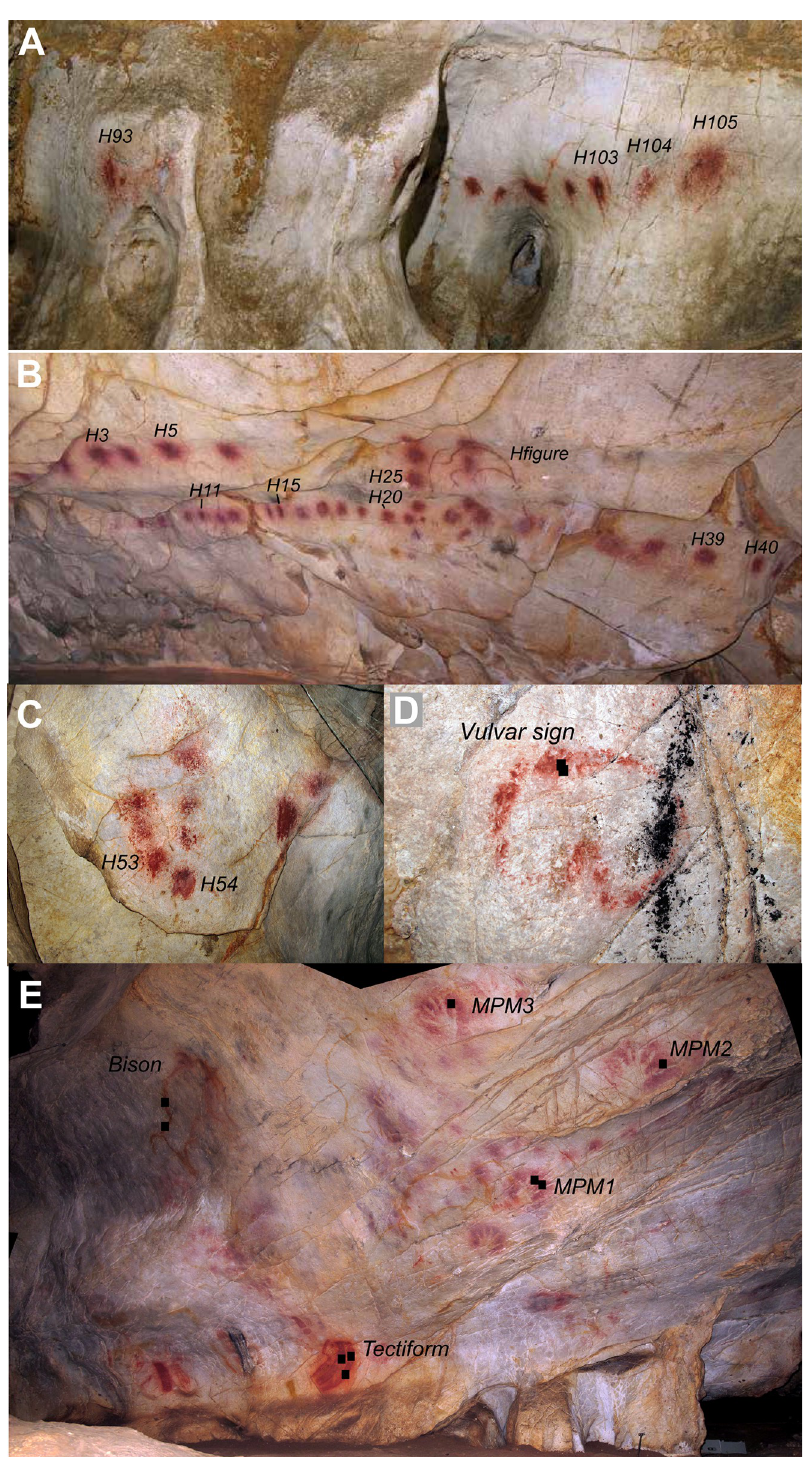
Fig 2. Pictures of the main paintings analysed in the present study. Black squares indicate where pXRF analyses were performed. A: Galerı´a de los Discos, beginning (H-1). B: Galerı´a de los Discos, end (H-3). C: Galerı´a de los Discos, middle (H-2). D: Panel de los Polı´cromos, Vulvar sign. E: Techo de las Manos.